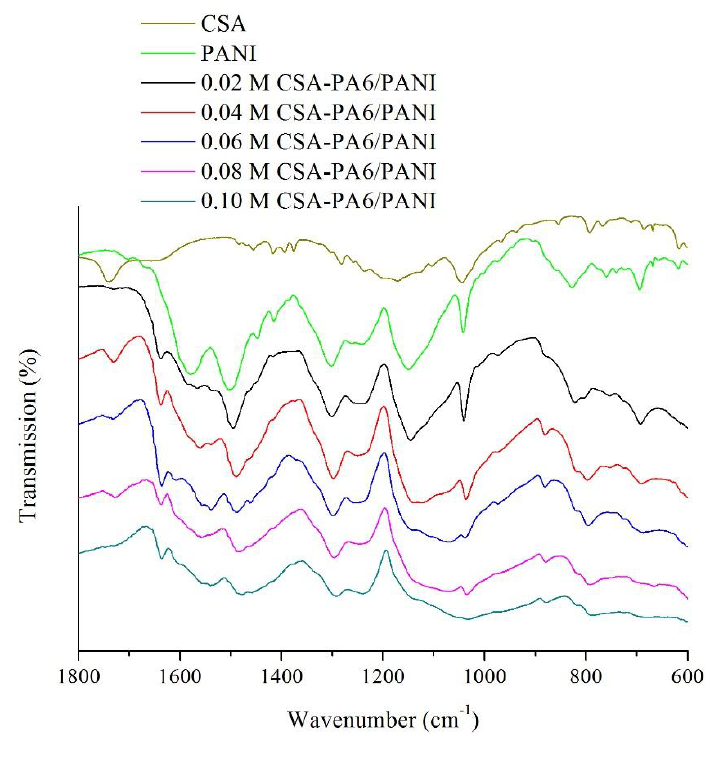
Figure 3. FTIR spectra of the pure CSA, pure PANI and the prepared CSA-PA6/PANI composite